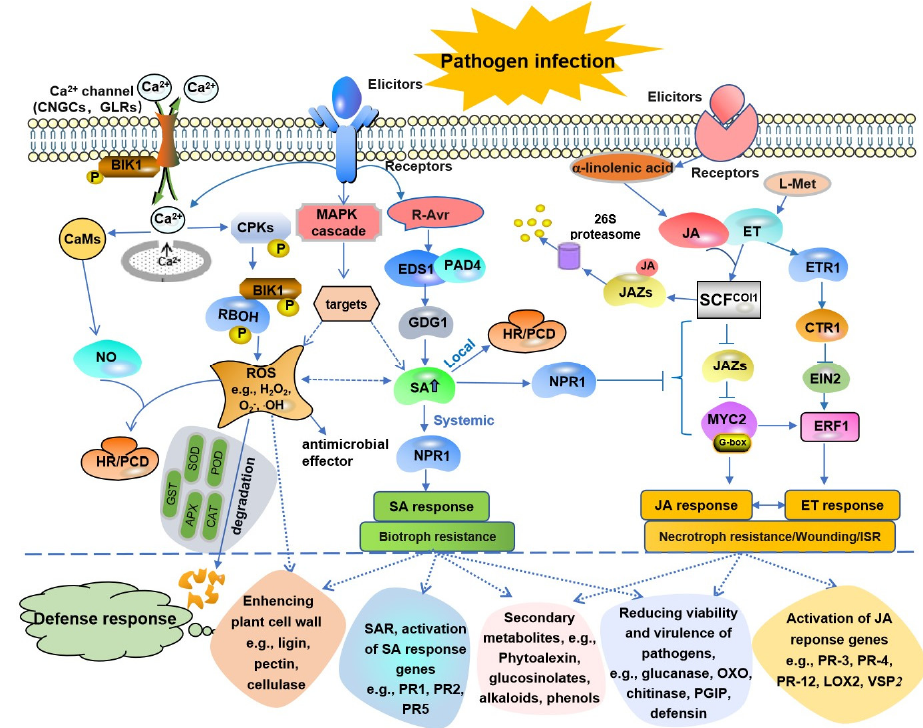
Figure 2. Schematic representation of the plant defense signal transduction network. In the process of plant–pathogen interactions, a series of signals are triggered to induce plant defense responses. The complex and diverse signal pathways interact with each other and form signal transduction networks in plants. After the resistant host recognizes the elicitors produced by pathogens, it activates the signal transduction system, causing the release of Ca 2+ , an MAPK cascade reaction, and the activation of R genes. Ca 2+ flowing into the cytoplasm can activate CaMs and CMLs, induce downstream NO synthesis, and then induce a primary immune response, including HR. Moreover, NO may regulate an HR/PCD through a synergistic effect with ROS. Besides being a signal to activate SAR, ROS can directly act as antibacterial effectors and enhance the structural resistance of the host. The interaction between the R gene and the avirulent gene ( Avr ) can stimulate a series of defense responses, such as the HR/PCD and SAR, which are induced by SA and give a strong resistance against some biotrophic pathogens. GDG1 is necessary for pathogen-induced SA biosynthesis, and its expression is regulated by EDS1 and PAD4 . SA can also control the expression of GDG1 , EDS1 , and PAD4 through a positive feedback loop. The positive feedback regulation of GDG1 lies in the high level of SA accumulation. JA/ET signaling pathways mainly regulate plant resistance to necrotic pathogens and wounds. JA and ET also mediate the resistance induced by root microorganisms, which is called induced systemic resistance (ISR). SA inhibits the JA/ET pathway by activating NPRl , a positive regulatory gene of the SA pathway. ERF1 is located at the intersection of the JA and ET signaling pathway defense against pathogen infections and in wound responses. A JA signal can promote the interaction between JAZ and the SCF COI1 ubiquitin ligase, resulting in the ubiquitination of the JAZ protein and degradation by the 26S proteasome, and then the activation of transcription factors such as MYC2 to induce JA responses. Ultimately, a series of downstream responses, such as the reinforcement of physical defensive structures, the production of secondary metabolites, the inhibition of growth pathogens by the induction of defensive proteins, the activation of the ROS scavenging system, and other disease resistance factors, are activated to fight against pathogen infection. CNGCs, cyclic nucleotide-gated channels; CaMs, calmodulins; CPKs, calcium-dependent protein kinases; GLR, glutamate receptor-like genes; NO, nitric oxide; POD, peroxidase; SOD, superoxide dismutase; CAT, catalase; APX, ascorbate peroxidase; GST, glutathione S-transferase; ROS, reactive oxygen species; RBOHD, respiratory burst oxidase homolog D; H 2 O 2 , hydrogen peroxide; O 2 − , superoxide ion; OH, hydroxyl radical; BIK1, BOTRYTIS-INDUCED KINASE1; MAPK, mitogen-activated protein